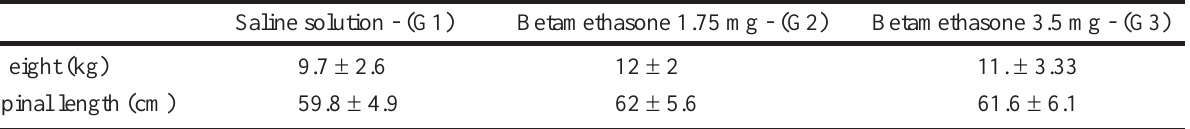
TABLE 1 - Animal weights and spinal lengths. Results are medians and SD